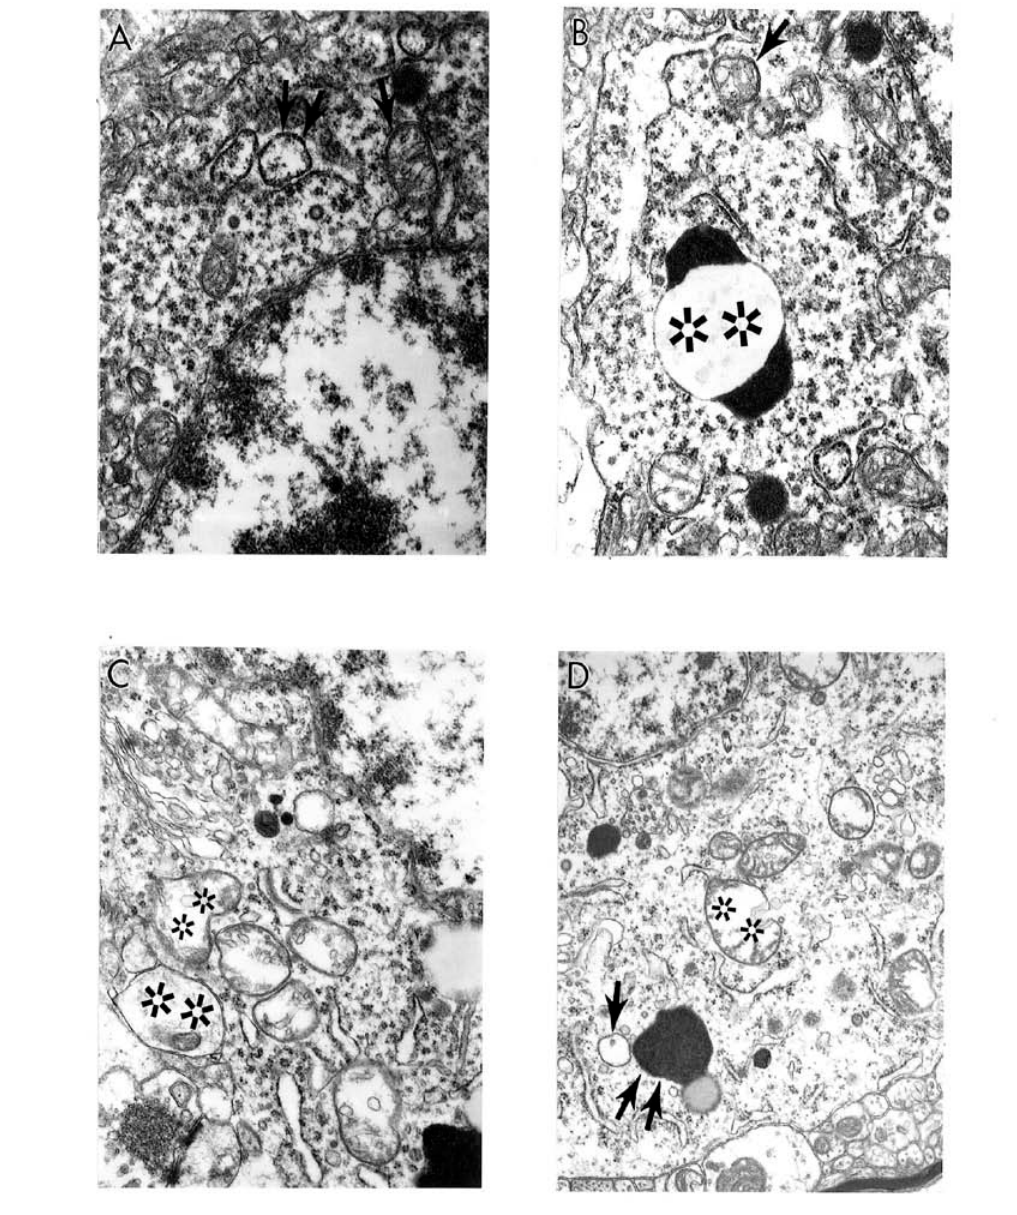
Figure 3. The ultrastructural characteristics of neuronal mitochondria damage from AD brain biopsy. Neurons with different degree of ultrastructural lesions. In the neuronal cell body partially and completely damaged mitochondria (indicated by single arrows and double asterisk respectively in A and C). The lesioned mitochondria appeared to be a major substrate for the lipofuscin formation (double arrow). The electron dense hypoxic mitochondria are seen throughout the cell body and characterize the abnormal mitochondrial cristae. Original magnification: A and B X20,000 respectively. C and D X 16,000 respectively (reprinted from [172] with